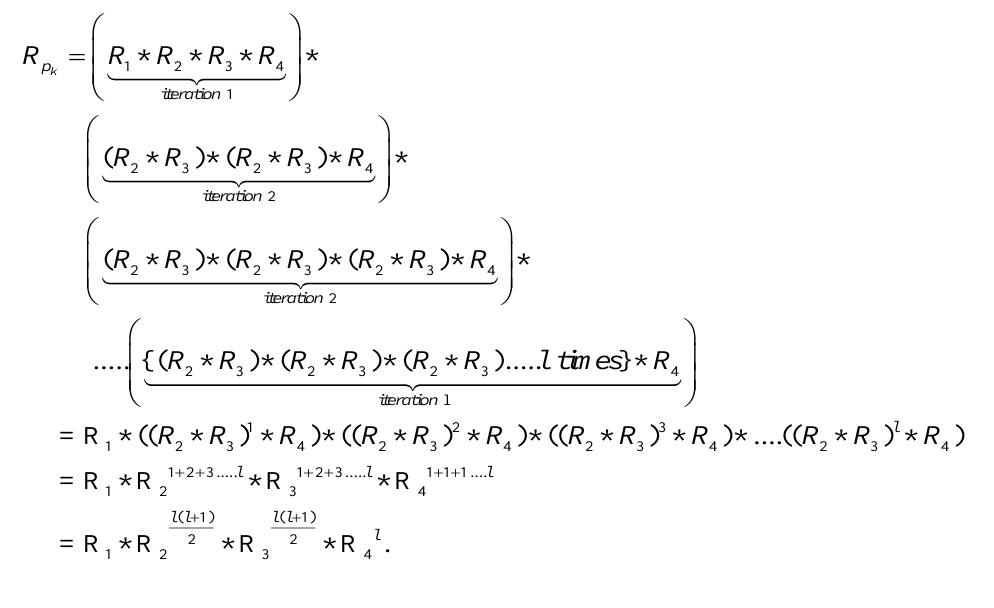
Figure 4. Loop structure and